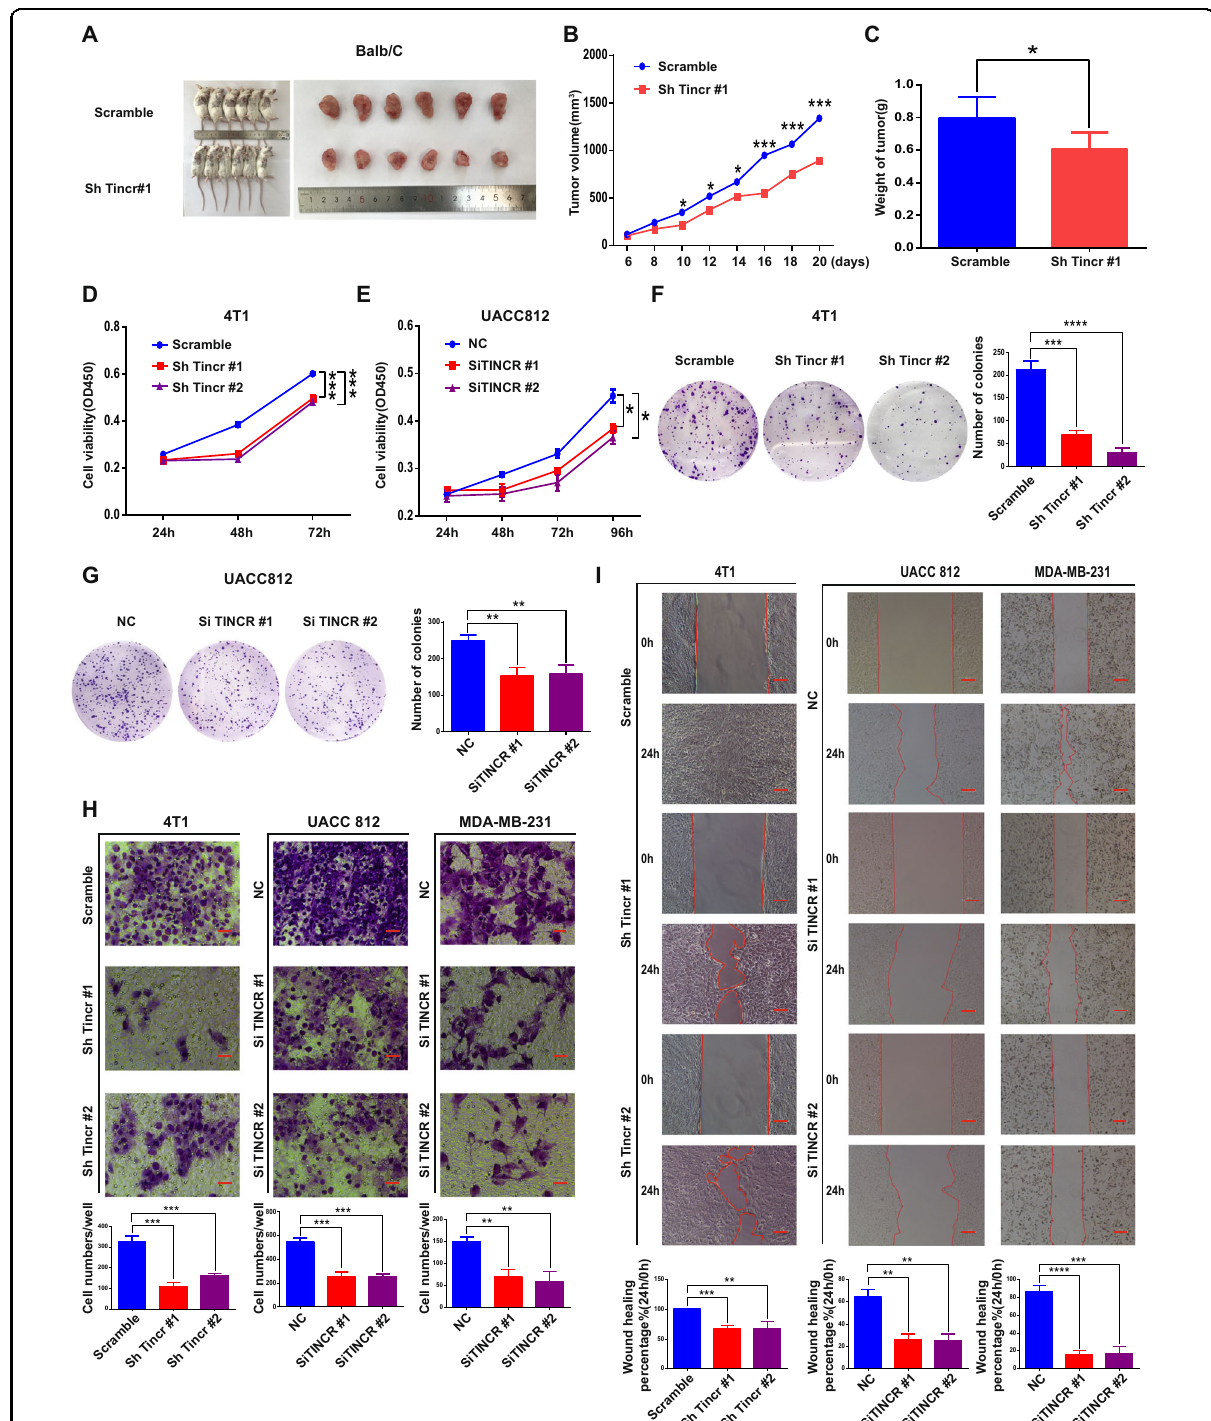
Fig. 3 TINCR promotes tumor growth in vivo and in vitro. a Tumorigenesis and tumor tissue of each group of Balb/c mice ( n = 6/group). b , c Tumor volume and weight measured in Balb/c mice after injection of 4T1 cells transfected with Tincr-speci fi c or scrambled-control shRNA. Tumor tissues were measured at the indicated time points and dissected at the endpoint. d – i Knockdown of Tincr/TINCR expression inhibits proliferation ( d , e ), colony formation ( f , g ), and migration ( h , i ) of 4T1, UACC 812, and MDA-MB-231 cells. Scale bar, 100 μ m. Data are presented as means from three independent experiments ± S.D. * P < 0.05, ** P < 0.01, *** P < 0.001, **** P < 0.0001.